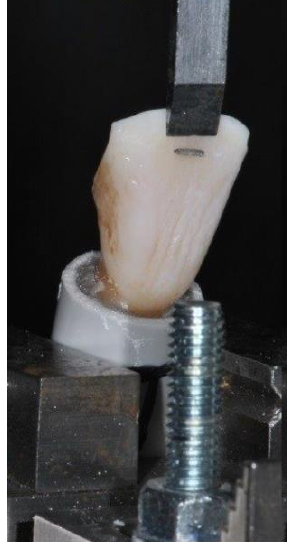
Figure 3. Positioning of specimens into the universal testing machine (three-quarter view).